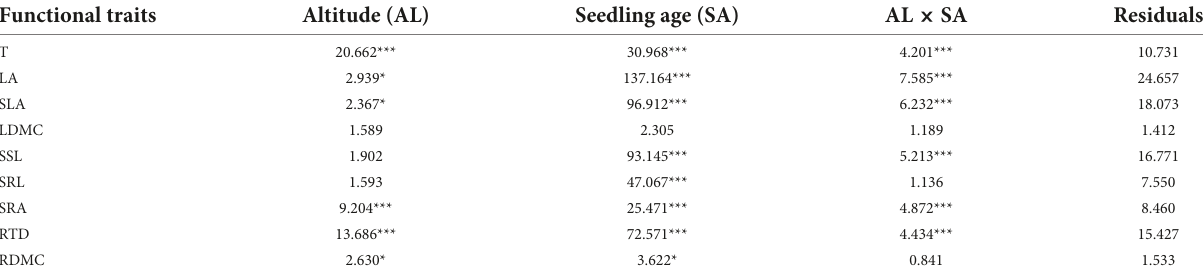
TABLE 2 Effects of altitude, seedling age and the interaction between altitude and seedling age on the functional traits of Abies georgei var. smithii seedlings. Functional traits Altitude (AL) Seedling age (SA) AL × SA